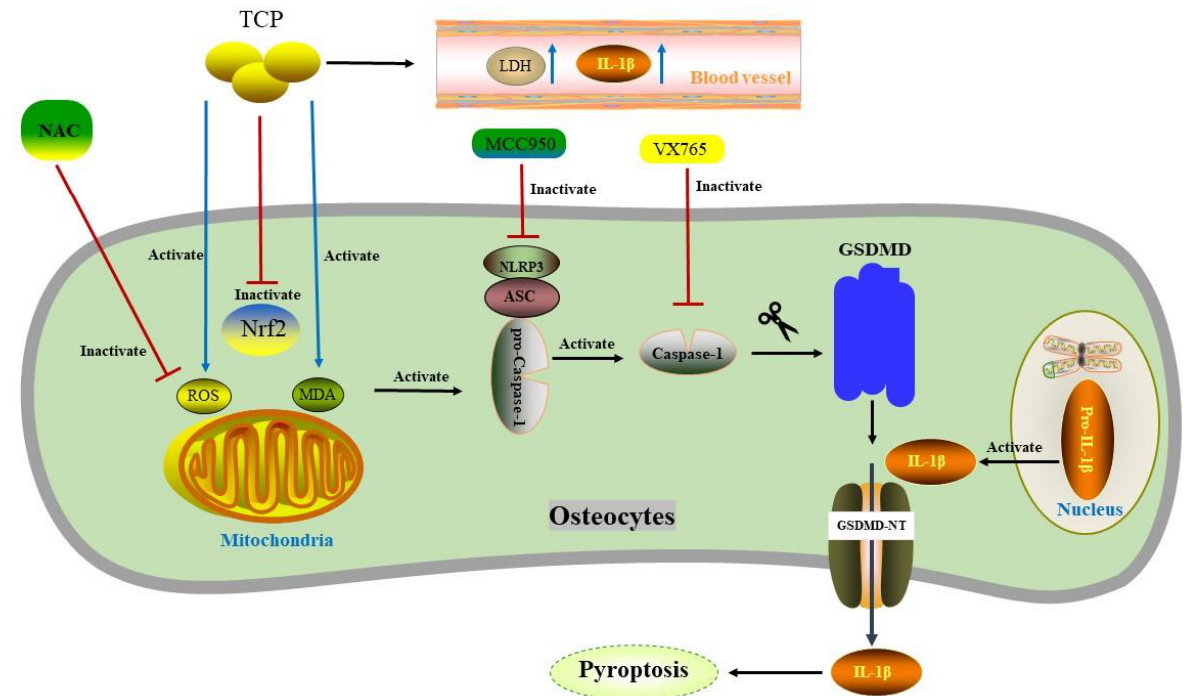
Figure 2. TCP-mediated pyroptosis of calvarial osteocytes. TCP up-regulates the levels of ROS and MDA in osteocytes, as well as the activation of NLRP3-mediated osteocytes pyroptosis. In addition, the concentrations of IL- 1β and LDH in serum increases. These effects can be reversed by the caspase-1 inhibitor VX765 or the NLRP3 inhibitor MCC950 or the ROS scavenger NAC. TCP: tricalcium phosphate. ROS: reactive oxygen species. MDA: malonaldehyde. Nrf2: antioxidant enzyme nuclear factor E2-related factor 2. LDH: lactate dehydrogenase. NAC: N-acetylcysteine.